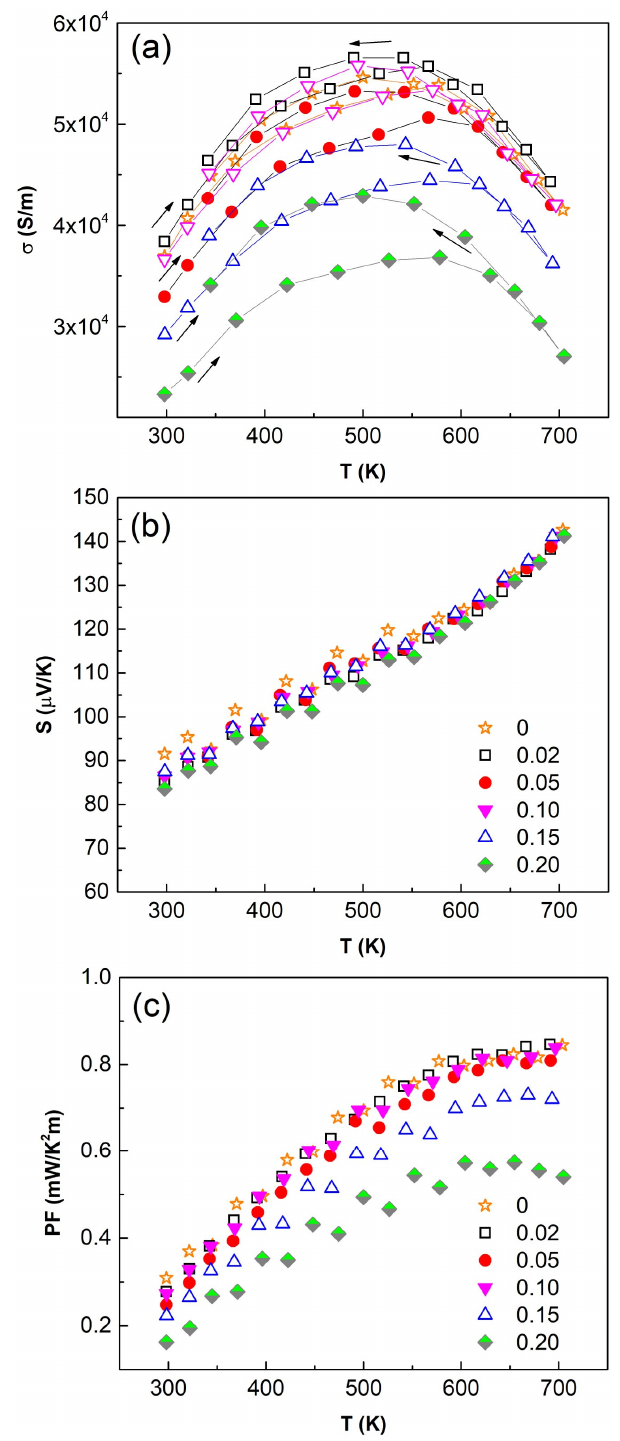
Figure 7. Temperature dependence of ( a ) electrical conductivity σ , ( b ) Seebeck coefficient S , and ( c ) power factor PF of sintered samples. Nominal Bi content, X Bi : see Figure. Therefore, the relatively high values of PF are achieved for the sample with the hi-ghest Bi content (X Bi = 0.2) which reaches 0.28 mW m − 1 K − 2 at 300 K and 0.85 mW m − 1 K − 2 at 700 K. Such values are in good agreement with other works on Bi-doped tetrahedrites [34,39]. As the carrier concentration seems unchanged with varying Bi content (similar Seebeck coefficient), the decrease of PF values for Bi-substituted samples are most likely due